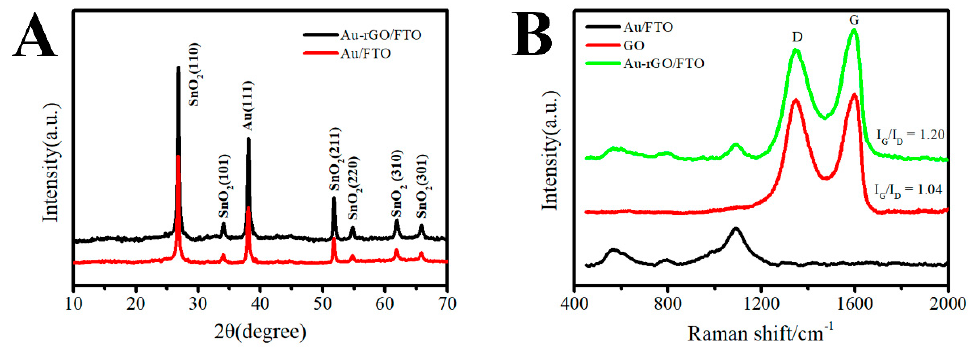
Figure 1. Typical XRD patterns ( A ) of 3D Au-rGO/FTO and Au/FTO, and Raman spectra ( B ) of GO/FTO, Au/FTO and 3D Au-rGO/FTO.